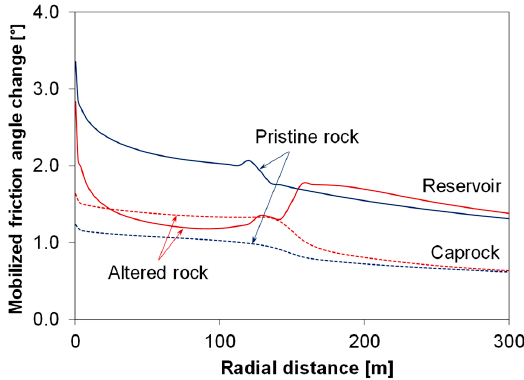
Figure 8. Changes in mobilized friction angle along the radial distance in the middle of the reservoir (continuous lines) and in the caprock, 10 m above the reservoir-caprock interface (dashed lines) for pristine and altered rock after 3 years of CO 2 injection.